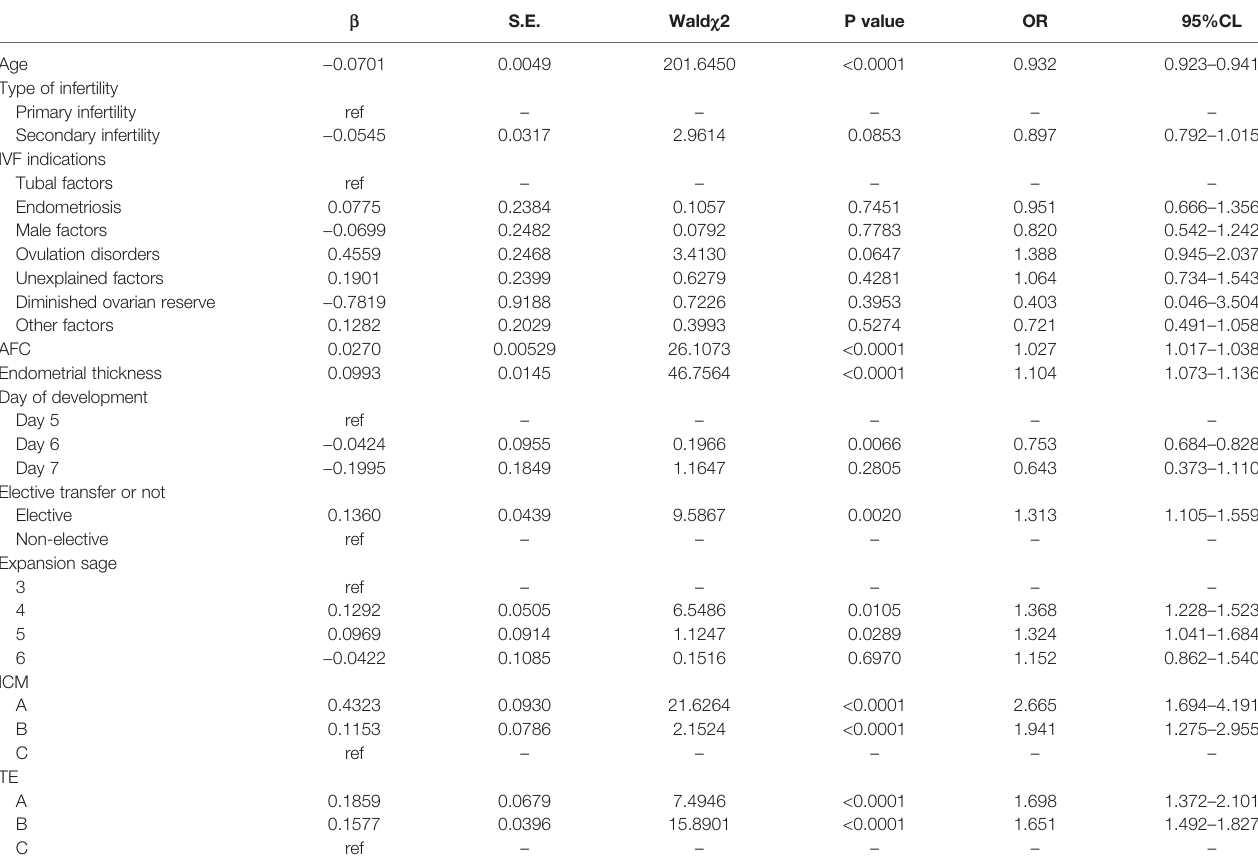
TABLE 5 | The results of the multiple logistics regression model for live